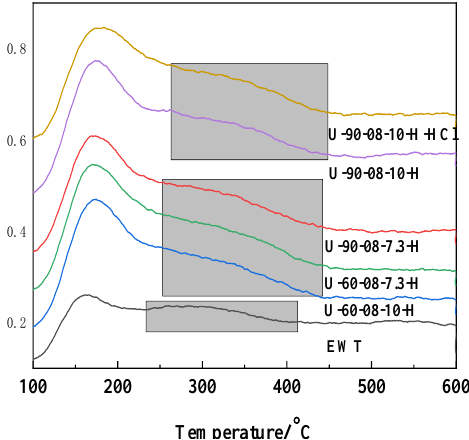
Figure 9. The NH 3 -TPD profiles of samples. Table 3. The acidity of samples by NH 3 -TPD and Py-IR.